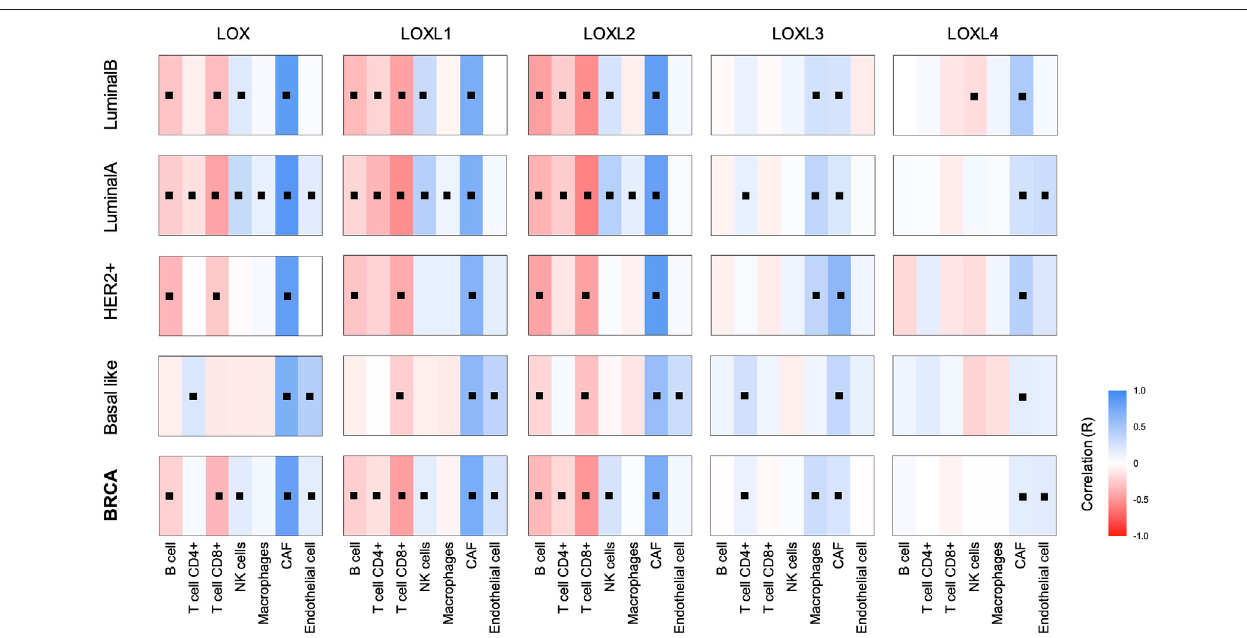
FIGURE 3 | LOX s expression and breast cancer tumour in fi ltrates. The correlations between expression of LOX family members and the abundance of immune in fi ltrates in BRCA and its subtypes were calculated based on the EPIC (Estimating the Proportion of Immune and Cancer cells) algorithm. Blue gradient represents a positive Spearman ’ s correlation and red gradient a negative correlation, ■ p < 0.05 (Spearman). Number of samples in each group: BRCA = 1100; Basal-like = 191; Her2+ = 82; LumA = 568; LumB = 219.